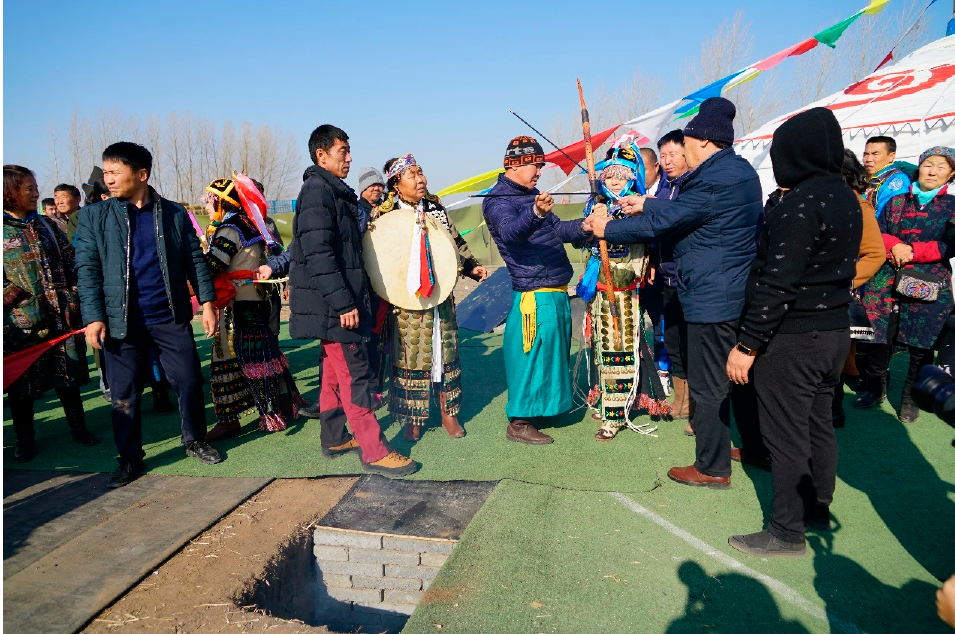
Figure A9. Shooting three arrows—to open the shamanic road (On 24 October 2017, Meng Yujin’s initiation ritual as jad’ ə n ). Photo: Minna Sa, 2017.